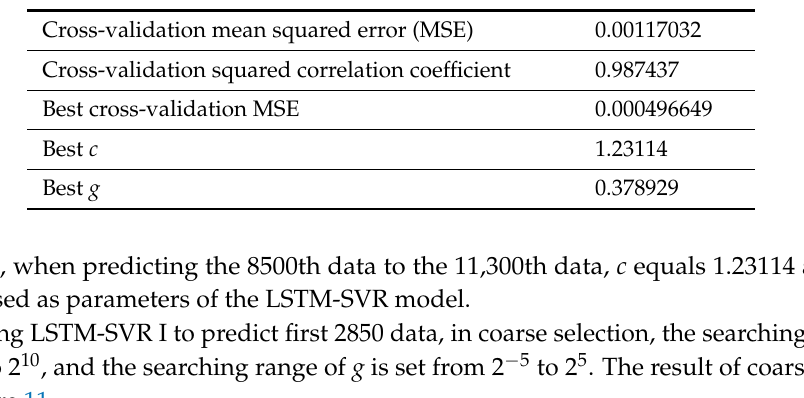
Table 3. Final result of fine selection.